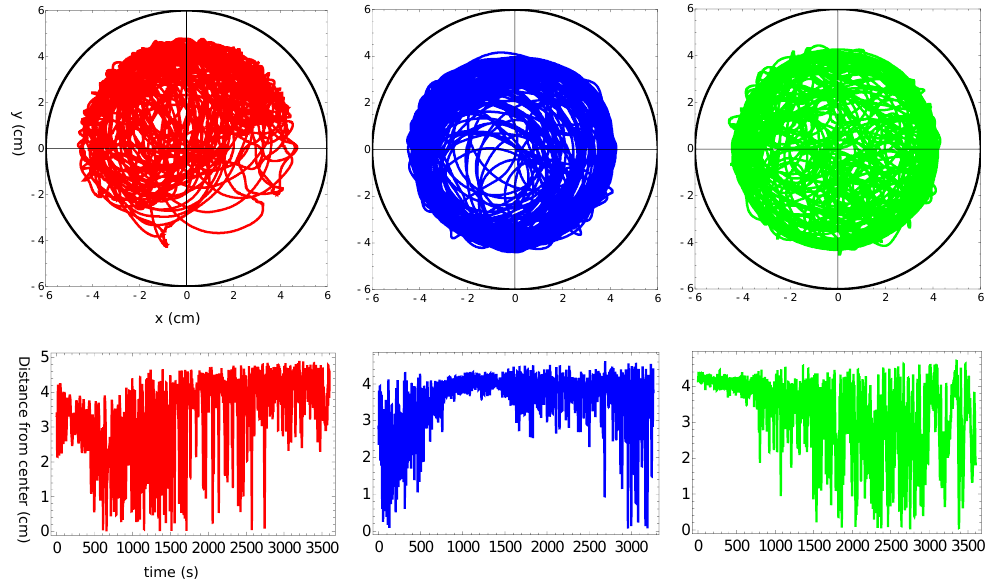
Figure 6. The upper three figures show the trajectories of a 4 mm pill made of 10% polypropylene and 90% camphene in a Petri dish with a 12 cm diameter. The black circle indicates the location of the dish wall. The distances between the pill center and the dish center as functions of time are plotted in the figures located below the corresponding